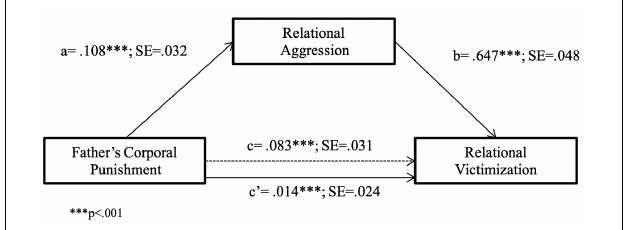
FIGURE 3 | Relational victimization predicted from father’s corporal punishment through relational aggression. ∗∗∗ p < 0.001.